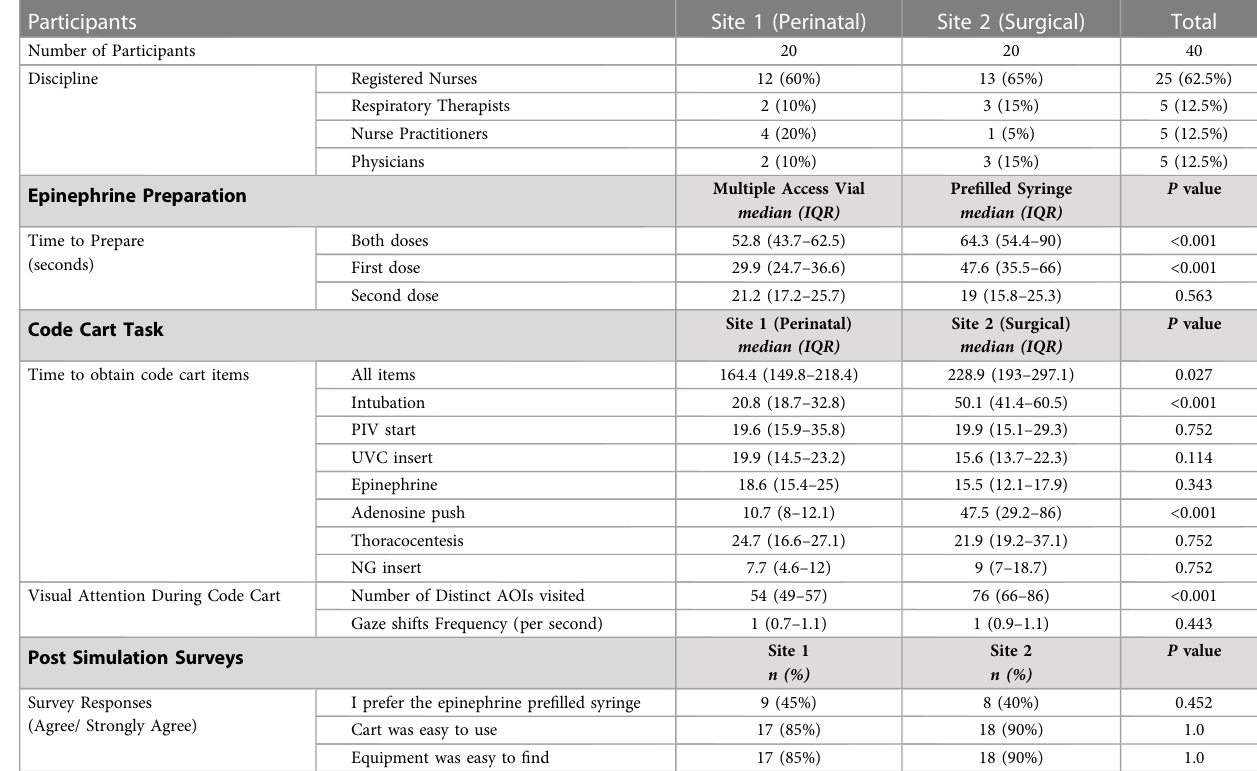
TABLE 1 Summary of participants and quantitative